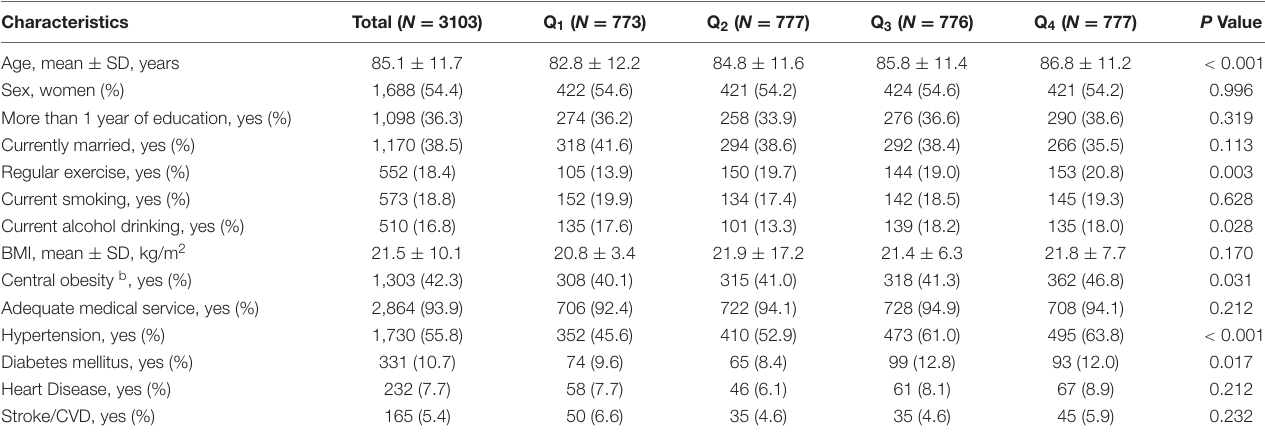
TABLE 2 | Baseline characteristics of study participants included in the main analysis, in total and by UA quartiles a .